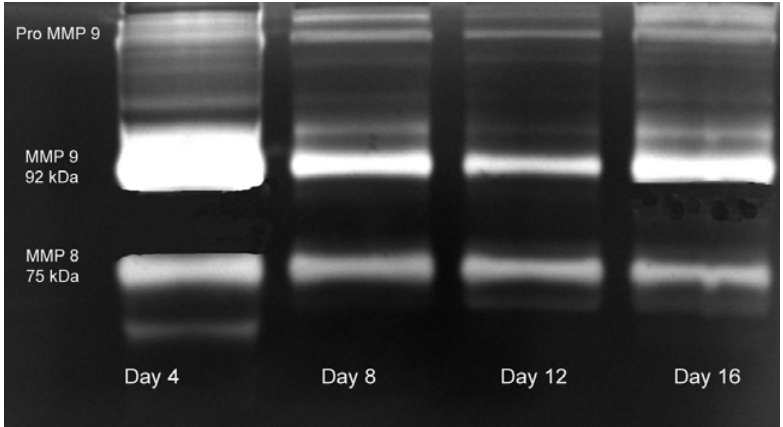
Figure 6. Zymogram shows the expression of MMPs in negative control rat